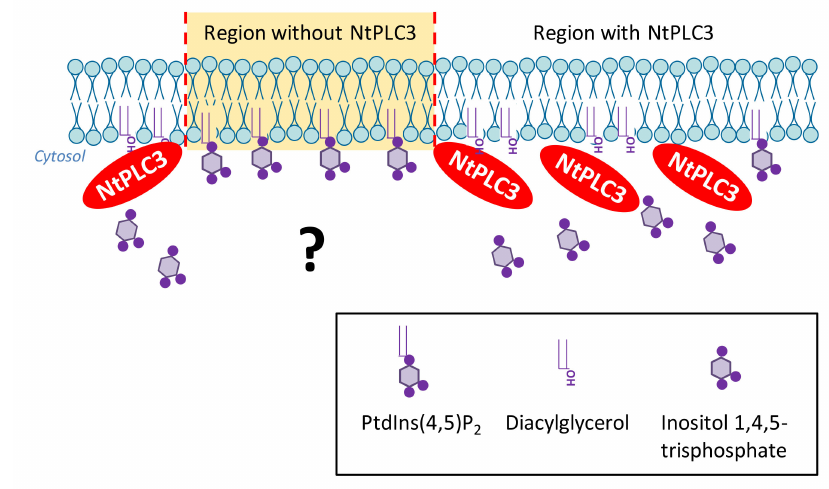
Figure 6. A simplified model of NtPLC3 antagonizing PtdIns(4,5)P 2 -formation. A possible role